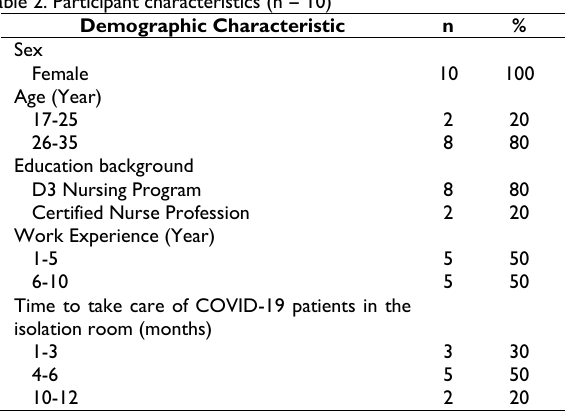
Table 2. Participant characteristics (n = 10) Demographic